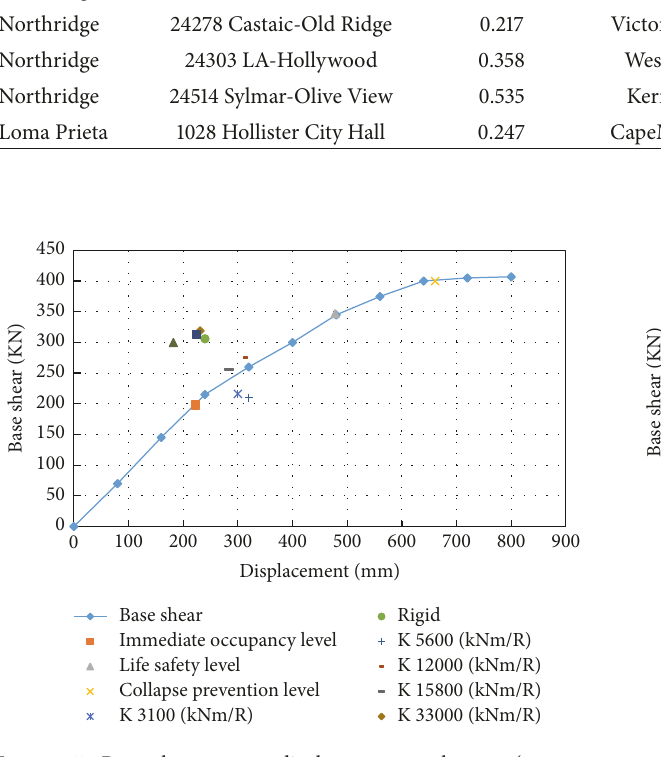
Figure 11: Base shear versus displacement at the top (5-storey frame). Figure 12: Base shear versus displacement at the top (10-storey